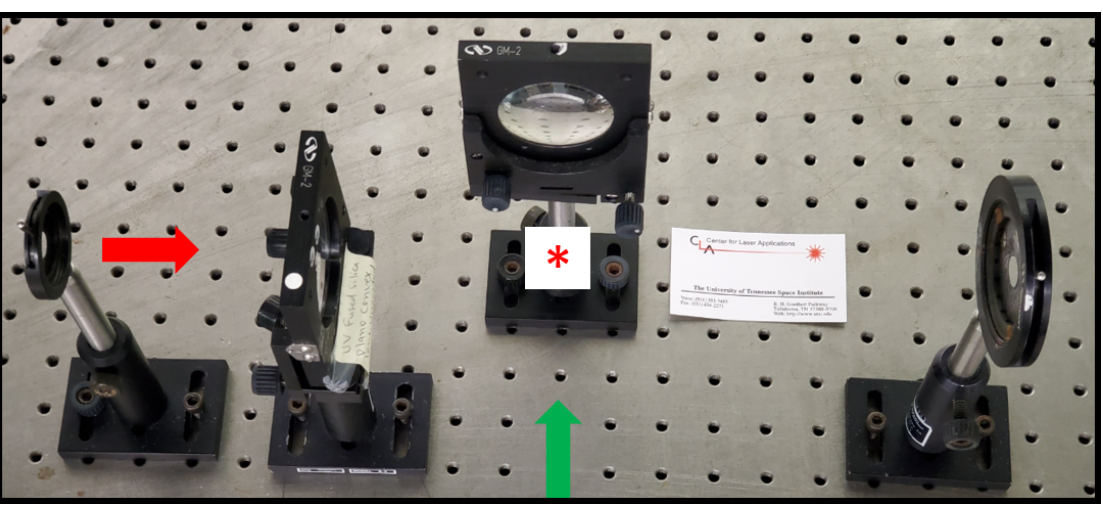
Figure 1. Module for recording shadowgraphs of optical breakdown in air. The collimated laser beam (red arrow) is focused with f/20 optics. The asterisk symbolically indicates optical breakdown. The interaction area is illuminated by a time-delayed laser beam (green arrow), and images are projected onto a screen (not shown) and recorded with a digital camera.